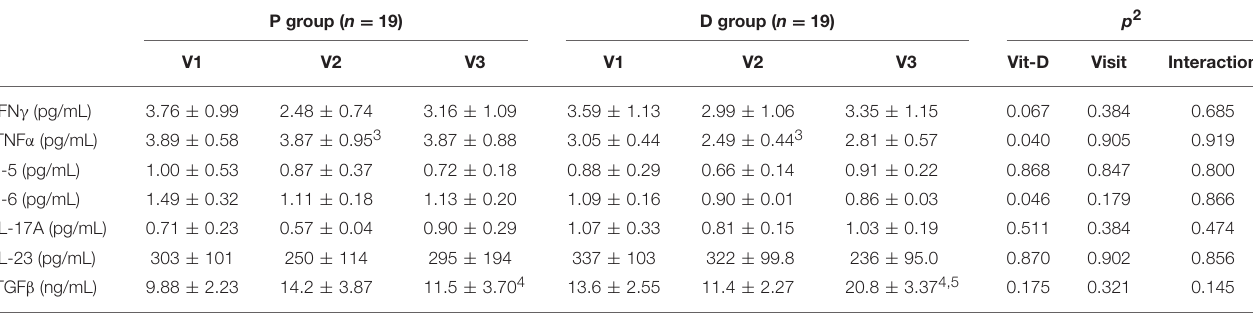
TABLE 3 | Cytokine plasma levels 1 .